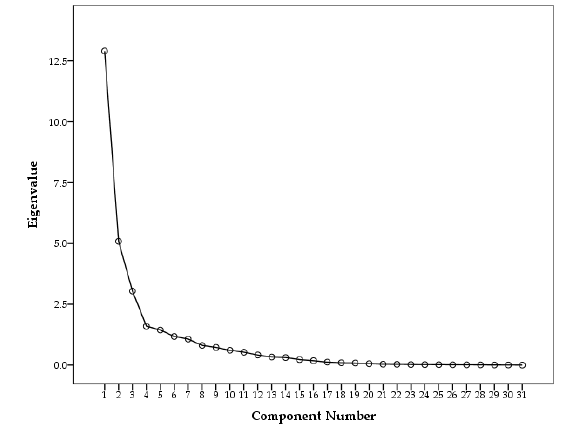
Figure 6. Scree plot of the Principle Component Analysis.